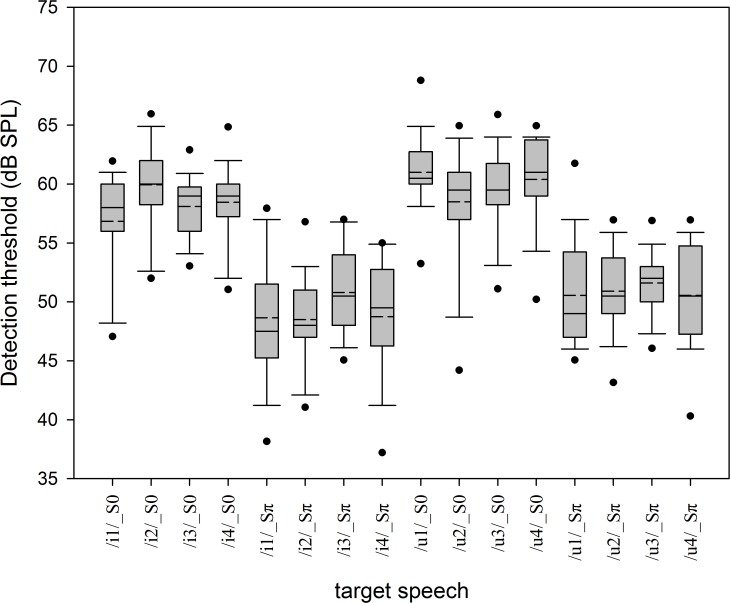
Average Mandarin tone detection thresholds in the S0N0 and SπN0 conditions.Each box plot shows the median (solid line), the mean (dash line), the 25th and 75th percentiles (box limits), the 10th and 90th percentiles (whiskers), and the 5th and 95th percentiles (black dots).